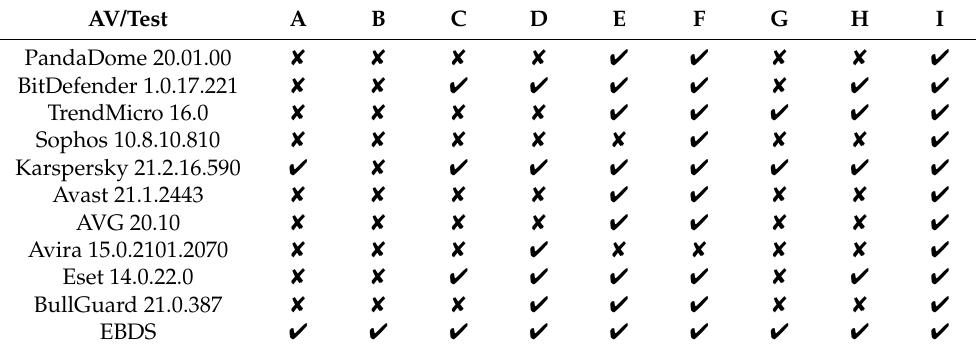
Table 3. Execution of malicious code modified using AES encryption. AV/Test A B C D E F H PandaDome 20.01.00 BitDefender 1.0.17.221 TrendMicro 16.0 Sophos 10.8.10.810